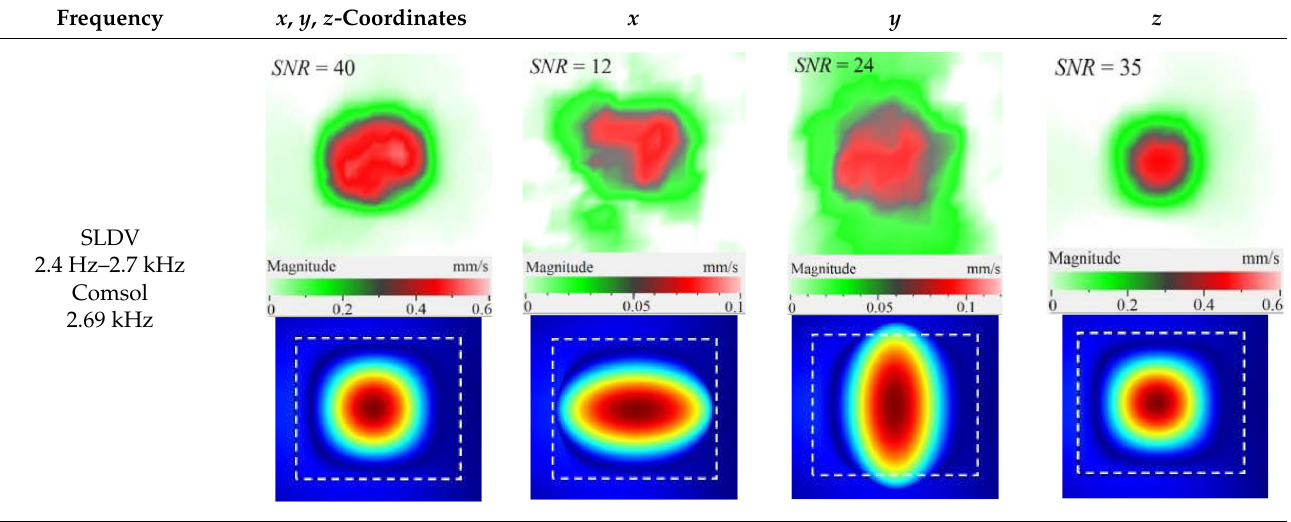
Table 1. Experimental and theoretical resonance harmonics for rectangular FBHs in the 50 Hz–13 kHz frequency range by x , y , z